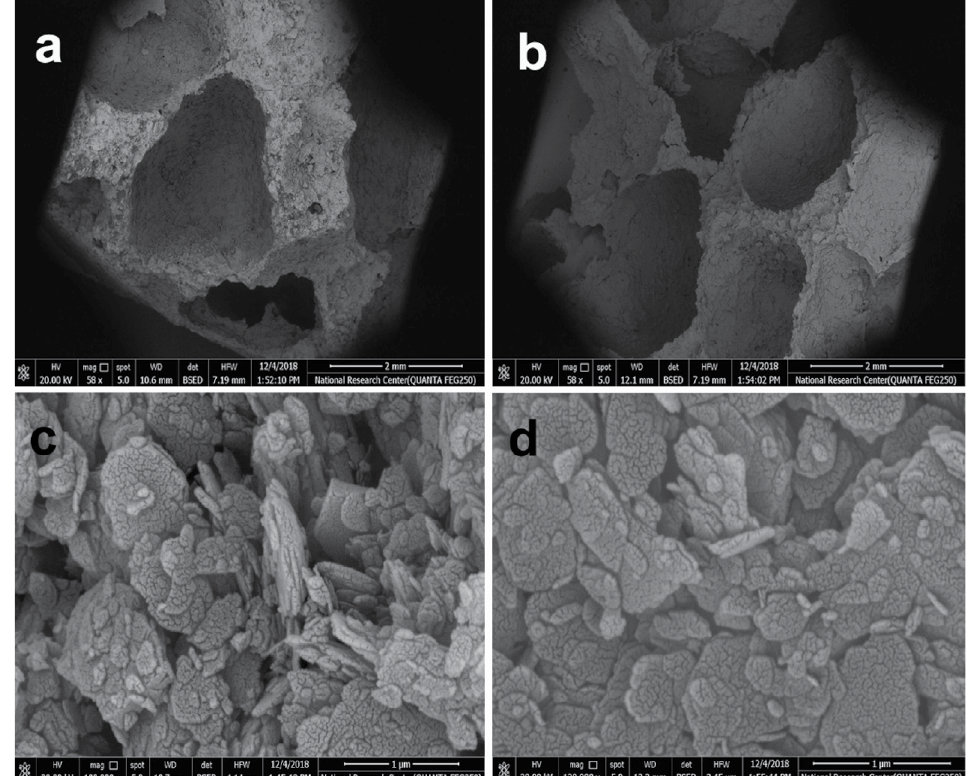
Figure 4. SEM of the ceramic membrane before and after MB